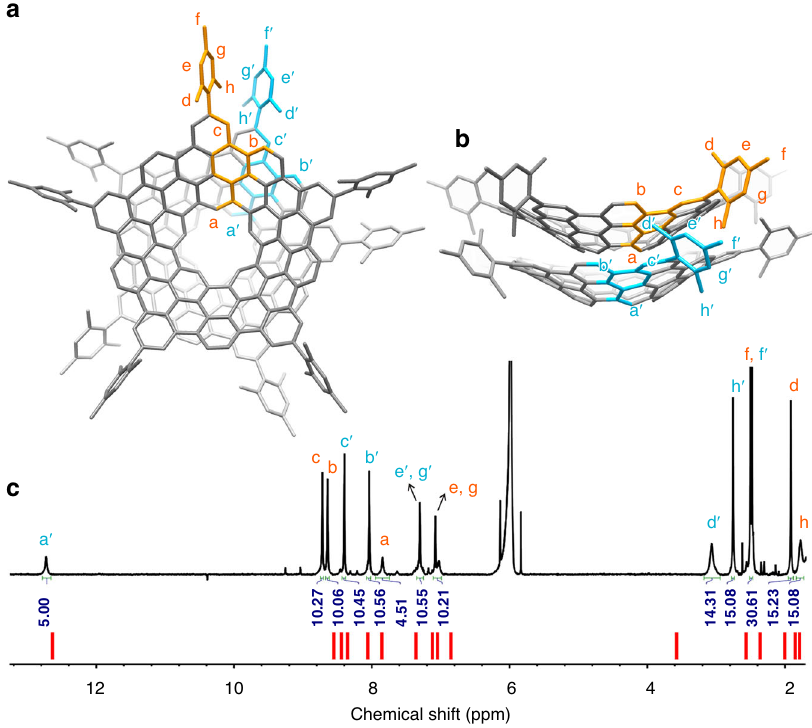
Fig. 5 NMR characterization of (1) 2 . a The top view of the DFT-optimized structure of ( 1 ) 2 . b The side view of the DFT-optimized structure of ( 1 ) 2 . The asymmetric unit is highlighted in orange for one layer and blue for another layer. The hydrogen atoms in the asymmetric units are numbered. c 1 H-NMR spectrum of ( 1 ) 2 measured in C 2 Cl 4 D 2 . The calculated NMR spectrum of ( 1 ) 2 is represented as red lines. Signal assignment is aided by 2D NMR spectroscopy and DFT calculations (see Supplementary Note 2, Supplementary Figures 17 and 27 – 30).